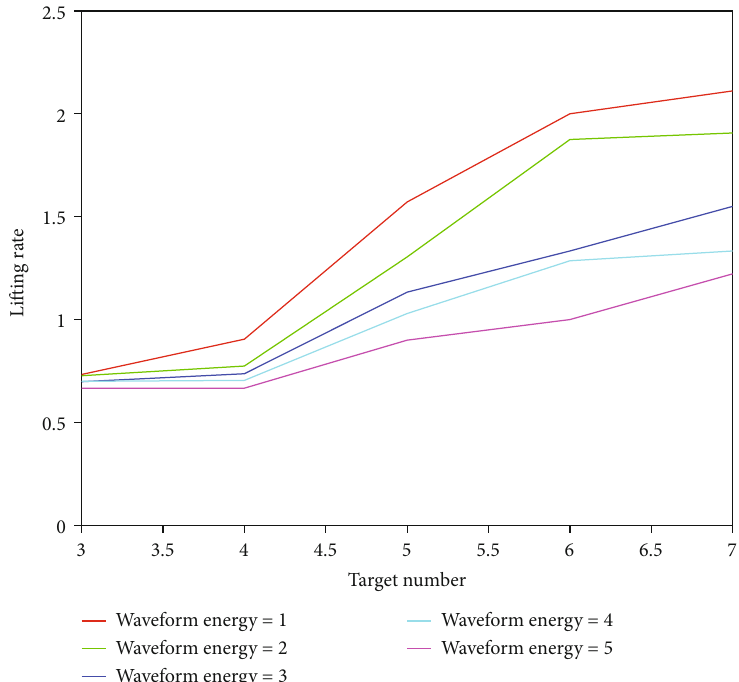
Figure 11: The relationship between the relative lifting rate and the number of targets in the situation of unequal probability target.